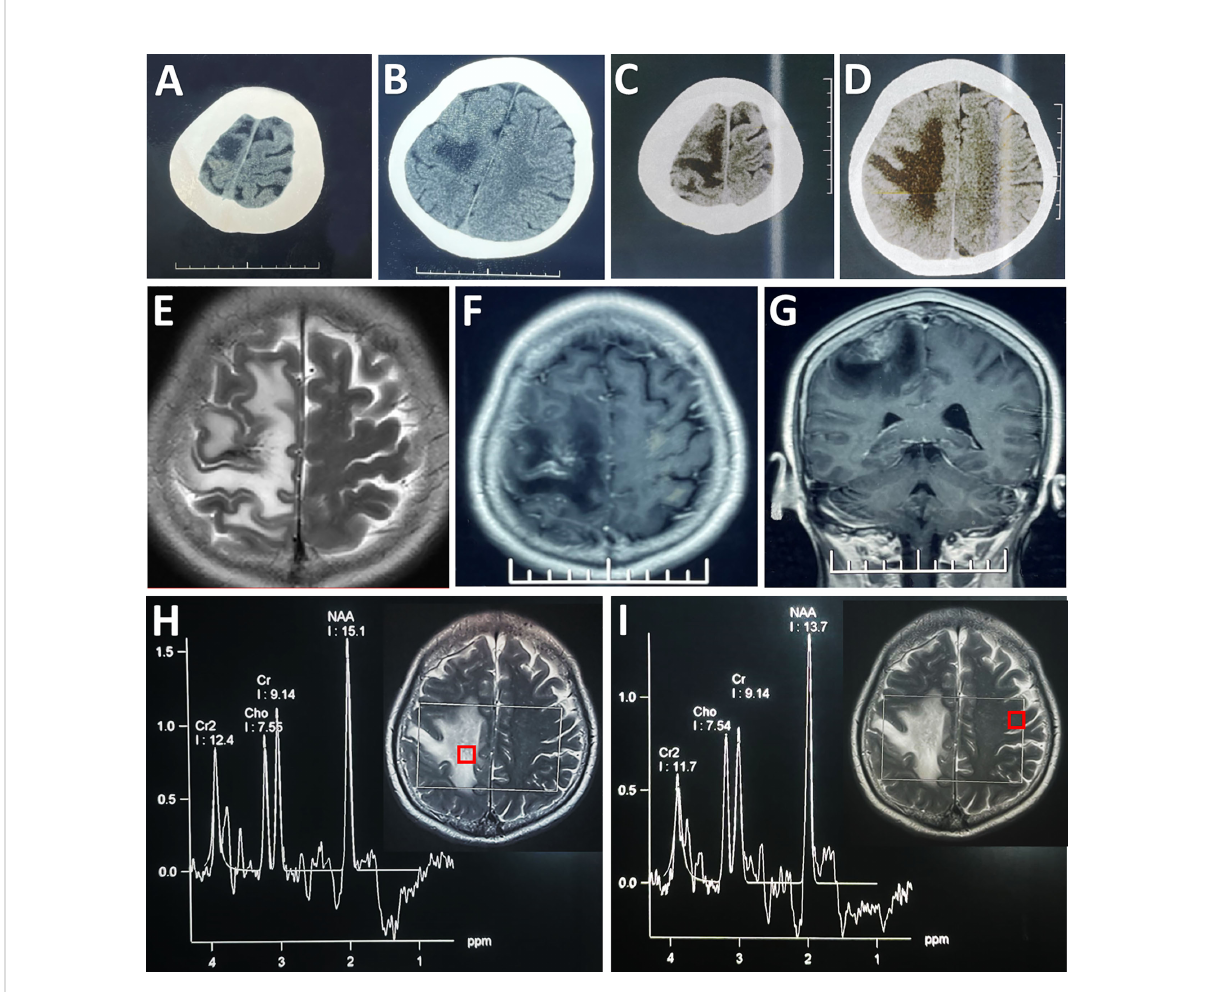
FIGURE 1 Radiological evaluation of the parenchymal lesion preoperatively. An initial CT scan showed a hypodense irregular mass located in the right frontal cortex (A, B) , which enlarged in size in the second scan performed 4 days later (C, D) . The lesion was hyper-intense on T2WI (E) . Post- contrast (gadolinium-enhanced) axial (F) and coronal MRI (G) showed prominent heterogeneous enhancement. MRS showed that there was no obvious change in the ratios of NAA/Cr (1.65) and Cho/Cr (0.83) in the lesion (H) compared with its counterpart (NAA/Cr: 1.50; Cho/Cr: 0.82) on the contralateral side (I) . Each region of interest in the MR images showed the location where the spectrum was